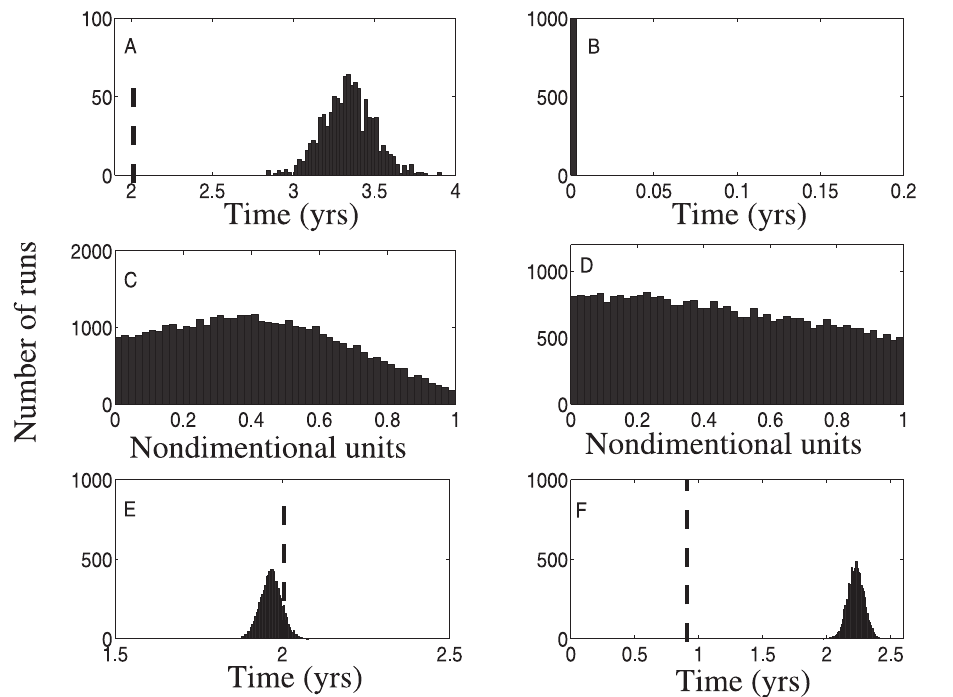
Figure 4. Failure of the regression method to accurately calculate standard deviations in data generation method 2. (A,B). Accuracy histogram of mean (panel A) and standard deviation (panel B) reconstruction for the first stage of a 4-stage disease using a data set of 10,000 patients created via method 2 with an inter-office interval mean of 1 year. Entry coefficients were assumed to occur uniformly. (C,D). Actual distribution of entry-stage completion coefficients for the transition classes 1 ? 2 (panel C) and 2 ? 3 (panel D) for the data in panels A and B. (E,F) Same as in panels (A,B) but the entry coefficients were assumed to be 1 (patients first visit the clinic at the beginning of their stages). The true values of the mean and the standard deviations are marked on histograms A, E and F by vertical lines.